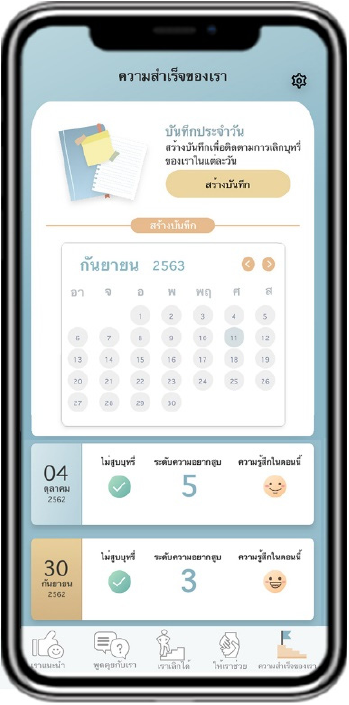
Figure 6. Display screen of Success of US.